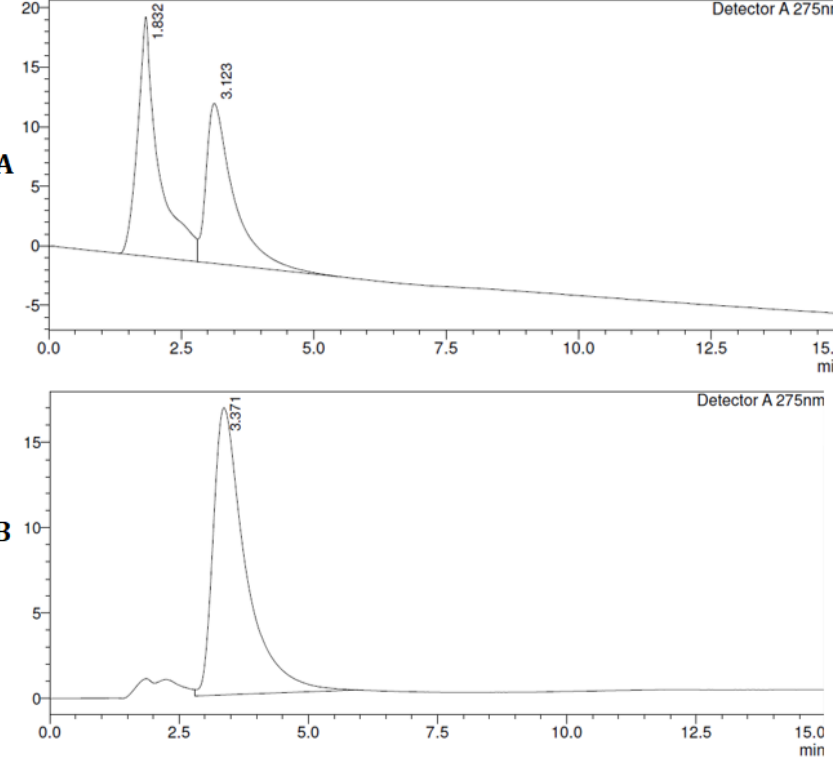
Figure 2. The images of HPLC profile Ficus septica leaf extract. A: extract; B: tylophorine; System: reversed- phase, Stationary phase: C18, mobile phase: methanol (100%), flowrate: 1mL/minute, detector: UV, wavelength: 275